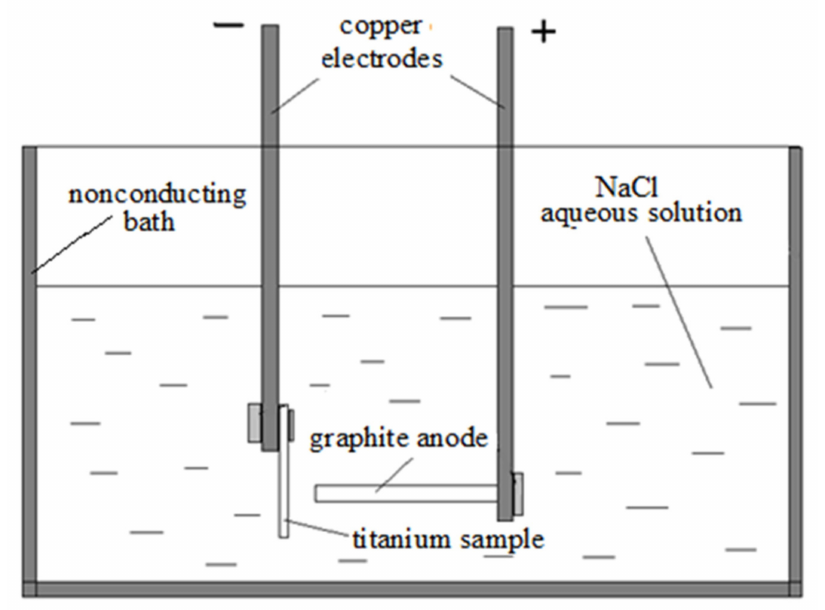
Figure 1. General scheme of samples